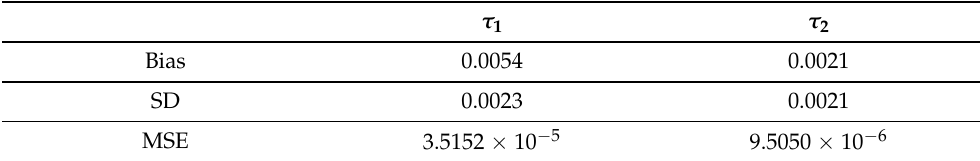
Table 4. Bias, SD and MSE according to the parameter τ for PLGSIMF with the identity link function and n = 1000.